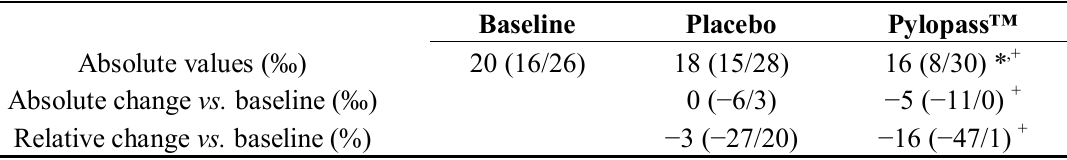
Table 2. Breath test findings in study population, results are reported as median (25./75. percentile).